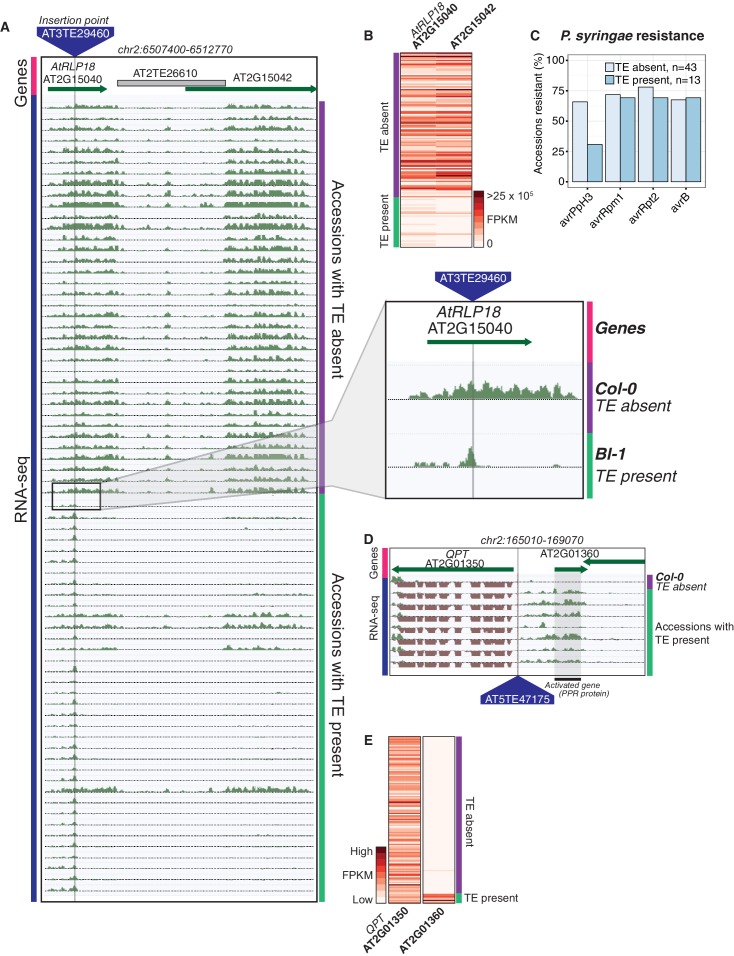
Effects of TE variants on local gene expression.(A) Genome browser representation of RNA-seq data for genes AtRLP18 (AT2G15040) and a leucine-rich repeat family protein (AT2G15042). All accessions predicted to contain the TE insertion are shown. Inset shows magnified view of the TE insertion site for two accessions. (B) AtRLP18 and AT2G15042 RNA-seq FPKM values for all accessions. (C) Percentage of accessions with resistance to Pseudomonas syringae transformed with different avr genes, for accessions containing or not containing a TE insertion in AtRLP18. (D) Genome browser representation of RNA-seq data for a PPR protein-encoding gene (AT2G01360) and QPT (AT2G01350), showing transcript abundance for these genes in accessions containing a TE insertion variant in the upstream region of these genes, as well as in Col-0. (E) RNA-seq FPKM values for QPT and a gene encoding a PPR protein (AT2G01360), for all accessions. Note that scales are different for the two heatmaps shown in E, due to the higher transcript abundance of QPT compared to AT2G01360. Scale maximum for AT2G01350 is 3.1 × 105, and for AT2G01360 is 5.9 × 104.